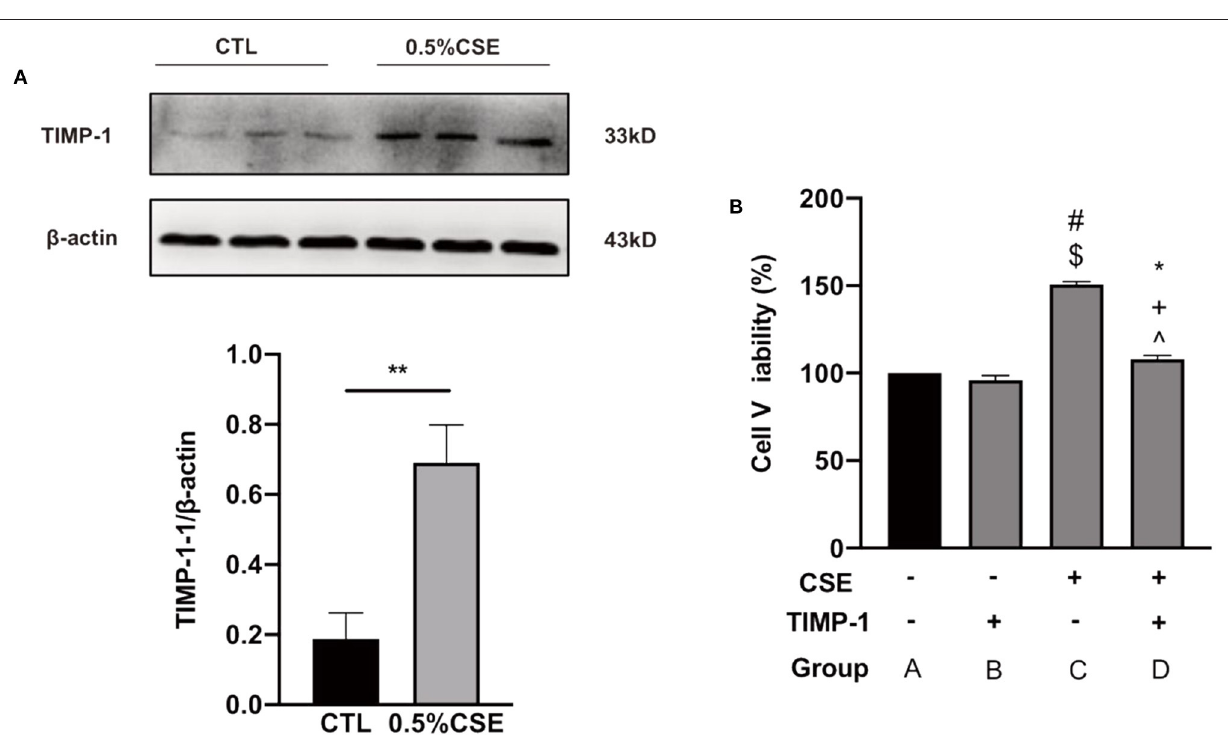
FIGURE 4 | CSE increased TIMP-1 level in cultured hPASMCs, and TIMP-1 decreased hPASMCs proliferation under CSE. (A) Western Blotting indicates 0.5% CSE treatment for 36h increased TIMP-1 expression in hPASMCs. (B) TIMP-1 attenuated CSE-stimulated hPASMCs proliferation. CSE, Cigarette Smoking Extract; hPASMCs, human Pulmonary Arterial Smooth Muscle Cell, ** P < 0.01 vs. Control group. TIMP-1, tissue inhibitor of metalloproteinase-1, CSE “ + ,” with the treatment of CSE; CSE “ − ,” without treatment of CSE; TIMP-1 “ + ,” with the treatment of TIMP-1; TIMP-1 “ − ,” without treatment of TIMP-1; # P < 0.01 vs. GroupA, $ P < 0.01 vs. Group B, * P < 0.05 vs. Group A, + P < 0.05 vs. Group B, ∧ P < 0.01 vs. Group C, N =